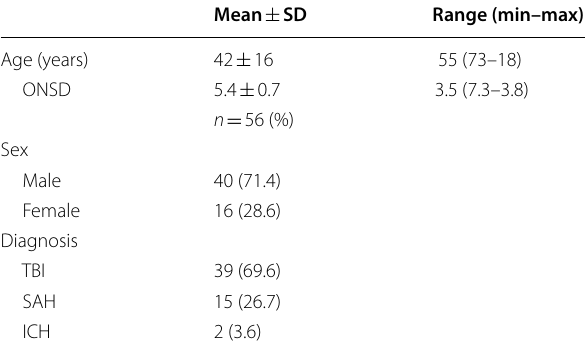
Table 1 Characteristics of the sample